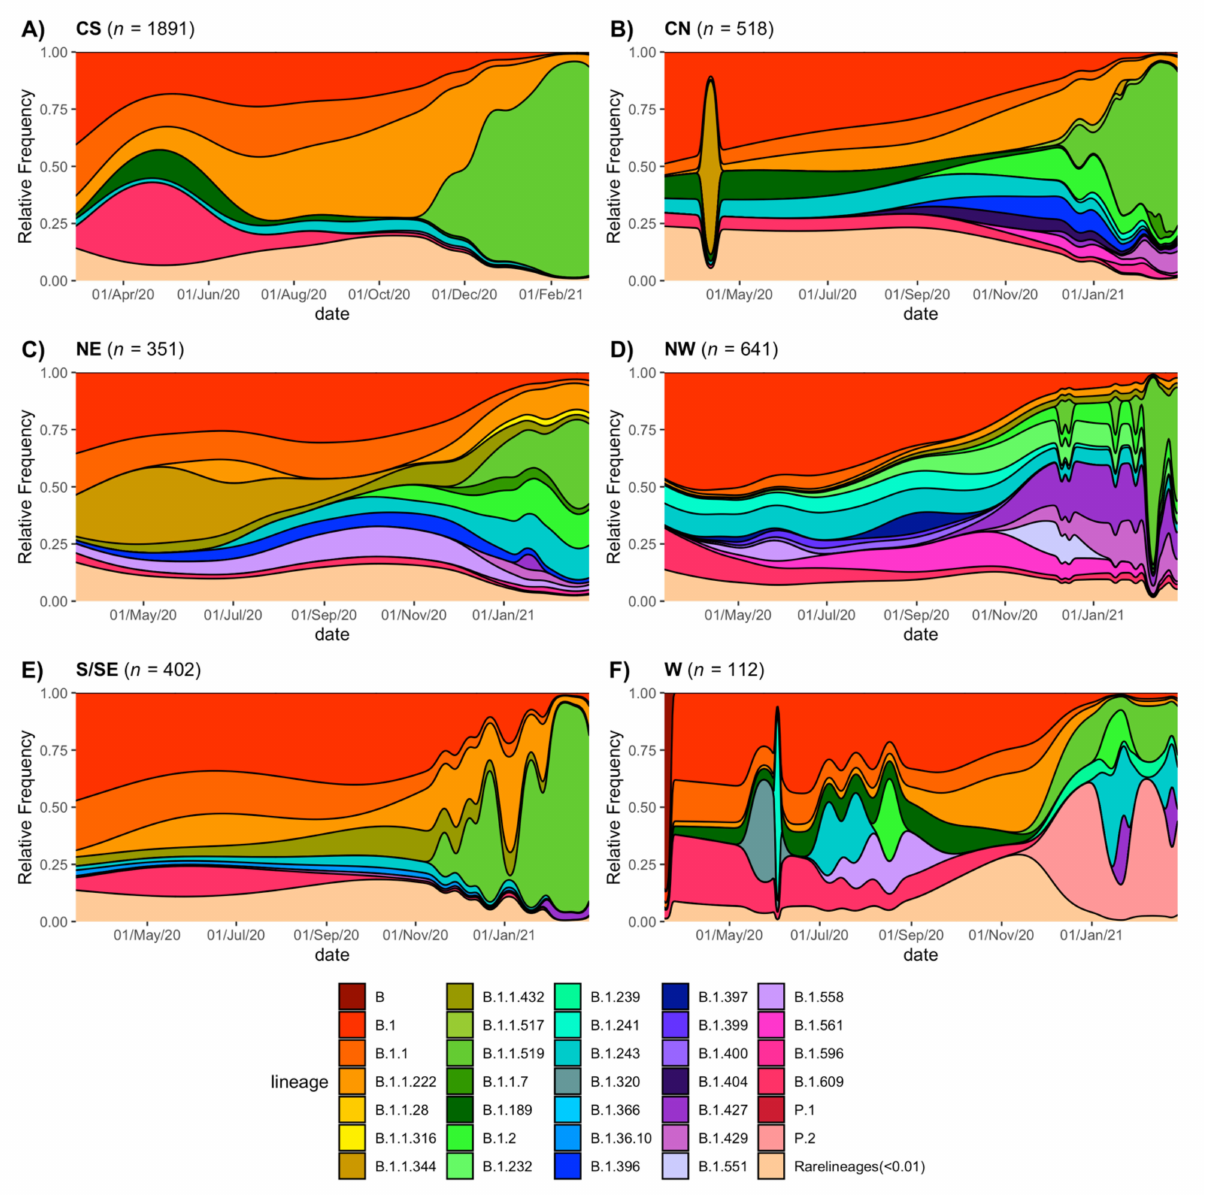
Figure 6. Circulation of SARS-CoV-2 lineages by region. Temporal distribution of lineages in each region ( A ) Central-South, ( B ) Central-North, ( C ) Northeast, ( D ) Northwest, ( E ) South/Southeast, and ( F )